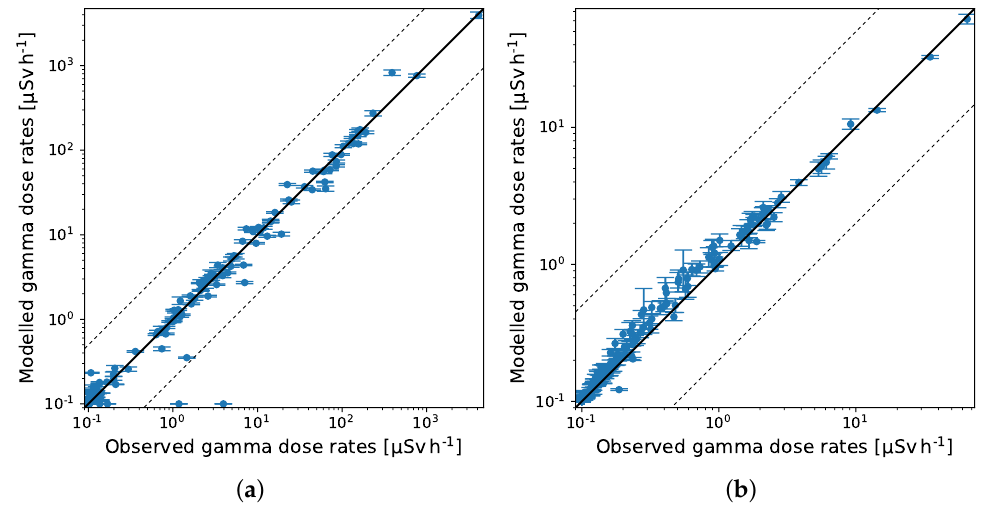
Figure 4. Model predictions with uncertainties (median and 10th and 90th percentile) on the y -axis, and observations on the x -axis. The solid black lines indicate a perfect correlation, while the dashed black lines indicate a factor of 5 between model and observation. ( a ) shows the filter measurements until 23 September, 08:00 UTC, i.e., the measurements that are used for the source term estimation, whereas ( b ) shows the filter measurements after 23 September, 08:00 UTC, i.e., predicted future air concentrations. ( c ) similarly shows the gamma dose rates until 23 September, 08:00 UTC, and ( d ) shows the gamma dose rates after 23 September, 08:00 UTC. Figure 5 shows the predicted gamma dose rates at the locations of six selected gamma stations, viz. the six stations that measured the highest values. The plots show that there is good agreement between modelled observed gamma dose rates and that even the time evolution is captured very well.